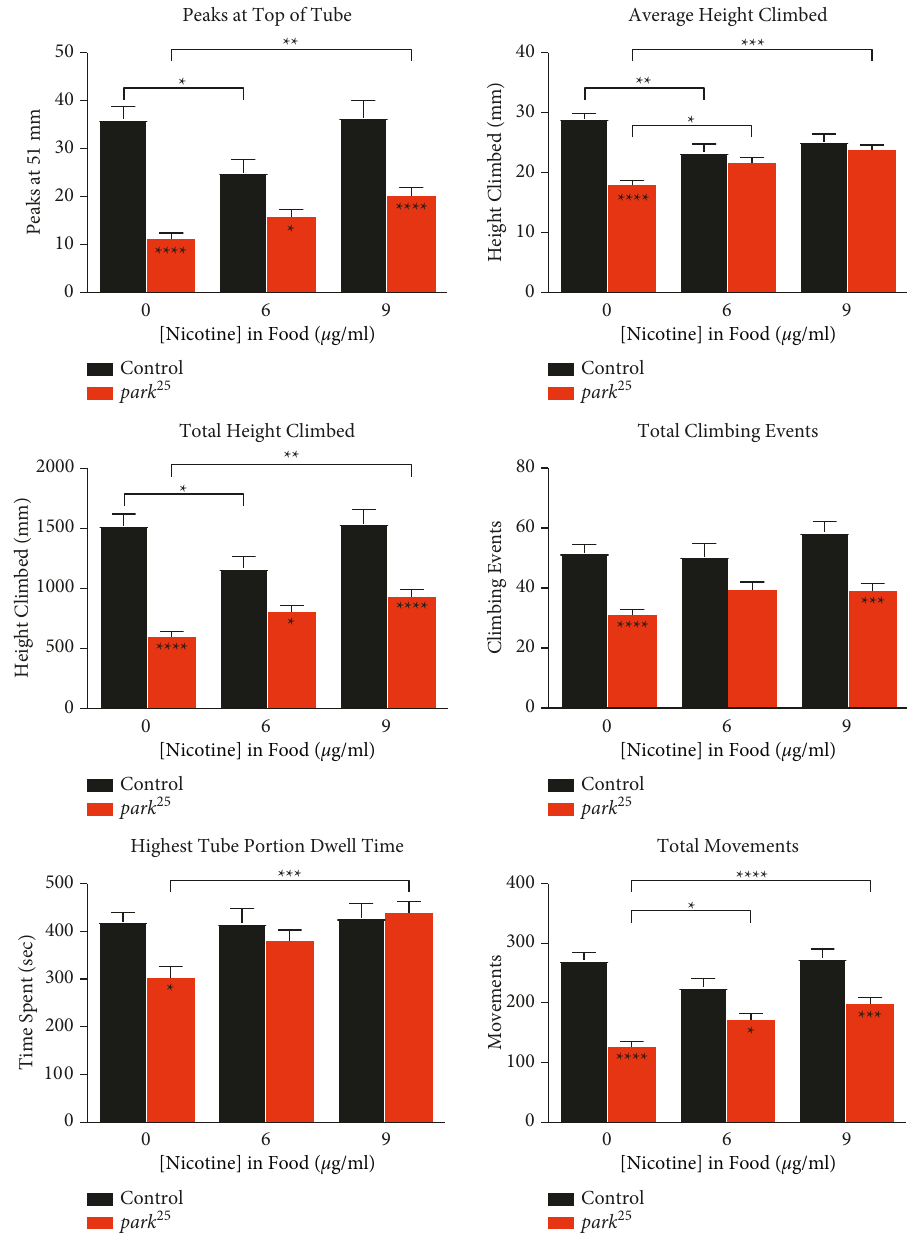
Figure 2: Nicotine treatment improves climbing deficits in park 25 homozygotes. Nicotine (6 and 9 μ g/mL) was given to homozygous park 25 flies compared to control flies from day 0. Different climbing metrics are shown, see Methods for definitions. Data are presented as mean and SEM. Results from a post hoc Tukey HSD analysis are shown. Asterisks inside the bars compare between the two genotypes at individual nicotine levels. ∗∗∗∗ � P < 0 . 0001, ∗∗∗ � P < 0 . 001, ∗∗ � P < 0 . 01 ∗ � P < 0 . 05. The results of each data point are from at least four separate experiments with an n ≥ 56